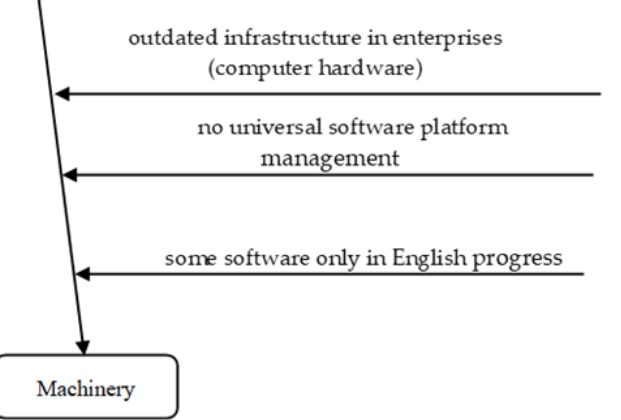
Figure 7. The reasons for the poor implementation of BIM in Poland in the Machinery